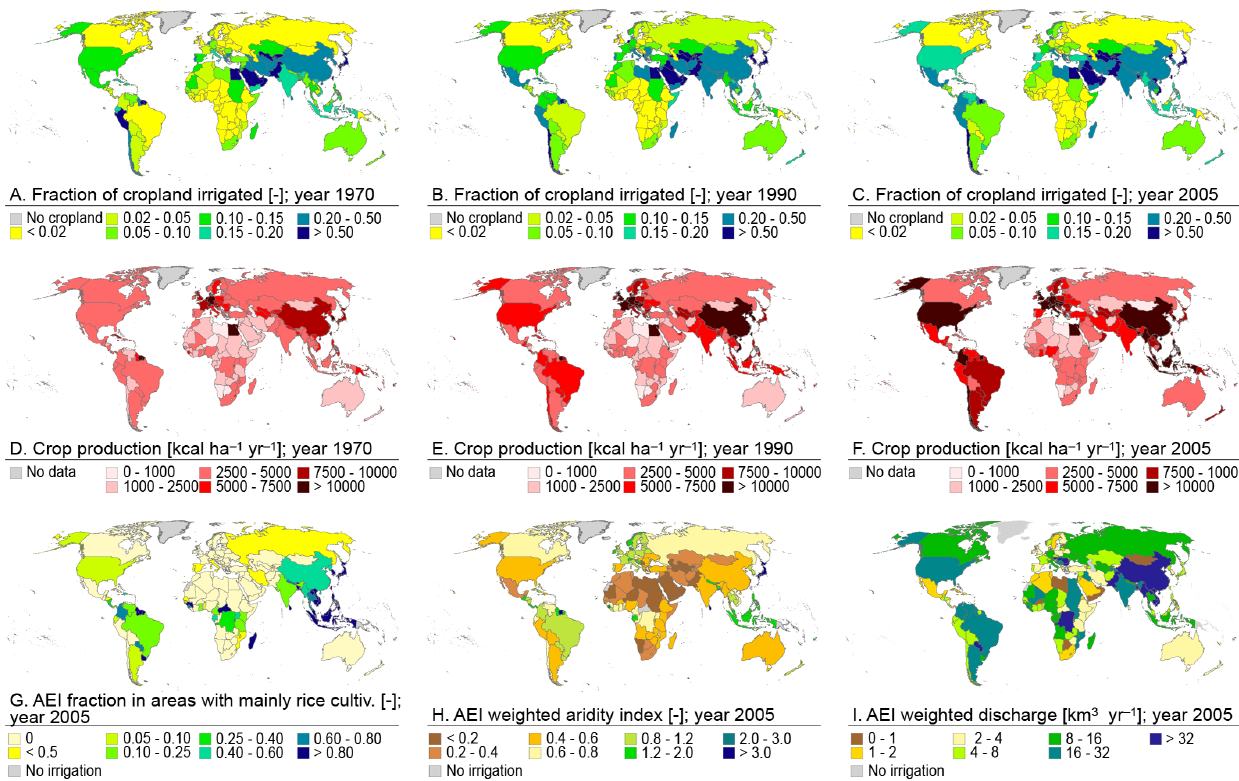
Figure 8. Ratio between the area equipped with irrigation according to the sub-national irrigation statistics (AEI_SU) used for the historical irrigation data set (HID) and cropland extent (a–c) or total cropland productivity (kcalhayr − 1 , d–f ) per country for years 1970 (a, d) , 1990 (b, e) and 2005 (c, f) ; fraction of AEI in regions with mainly rice irrigation (g) , mean aridity weighted with AEI (h) , and mean river discharge weighted with AEI (km 3 yr − 1 , I). Cropland productivity (kcalha − 1 yr − 1 ) was calculated based on crop production data for years 1969–1971 (d) , 1989–1991 (e) and 2004–2006 (f) and cropland extent for years 1970, 1990 and 2005 extracted from the FAO FAOSTAT database (FAO,